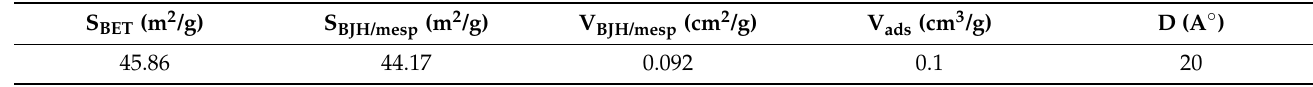
Table 1. Textural properties of the